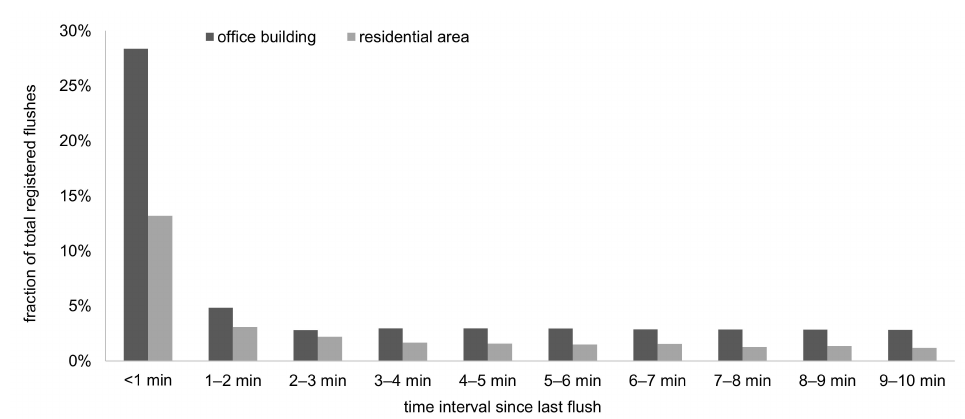
Figure 1. Fraction of total registered flushes for different ranges of time intervals to the last flush at the same